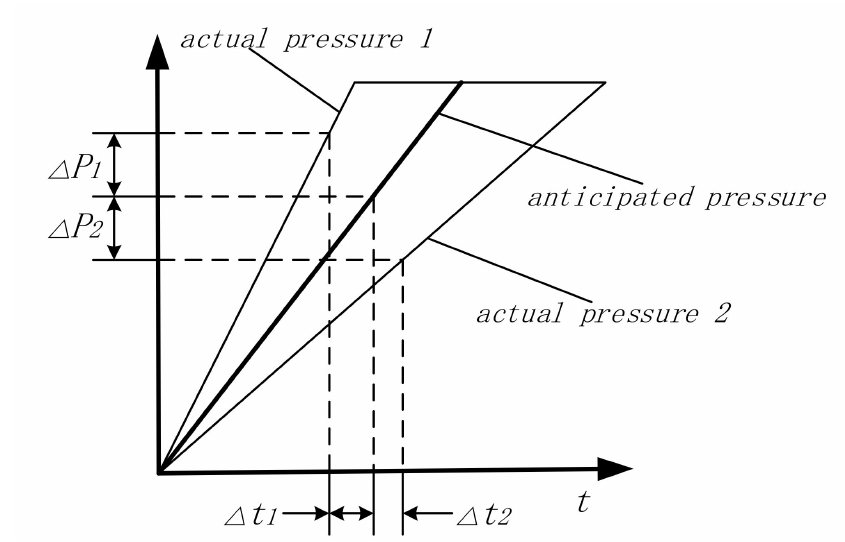
Figure 3. Schematic diagram of pressure-time relationship.